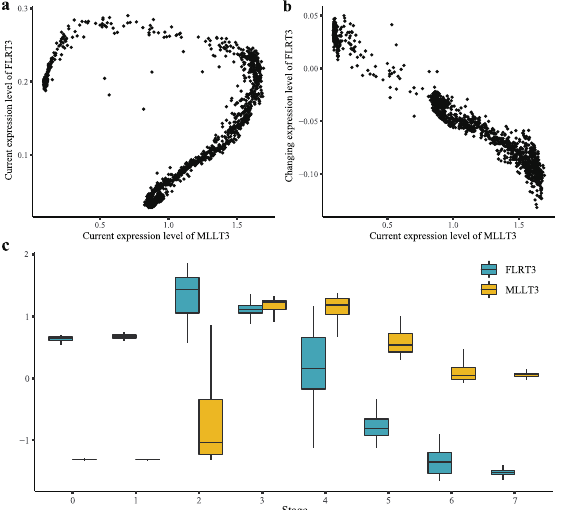
Figure 6. MLLT3 → FLRT3 . ( a ) Scatter plot of the current expression levels of MLLT3 and FLRT3 . ( b ) Scatter plot of the current expression level of MLLT3 and the changing expression level of FLRT3 . ( c ) Box plots of the normalized current expression levels of MLLT3 and FLRT3 at eight stages, which was identified by pre-defined